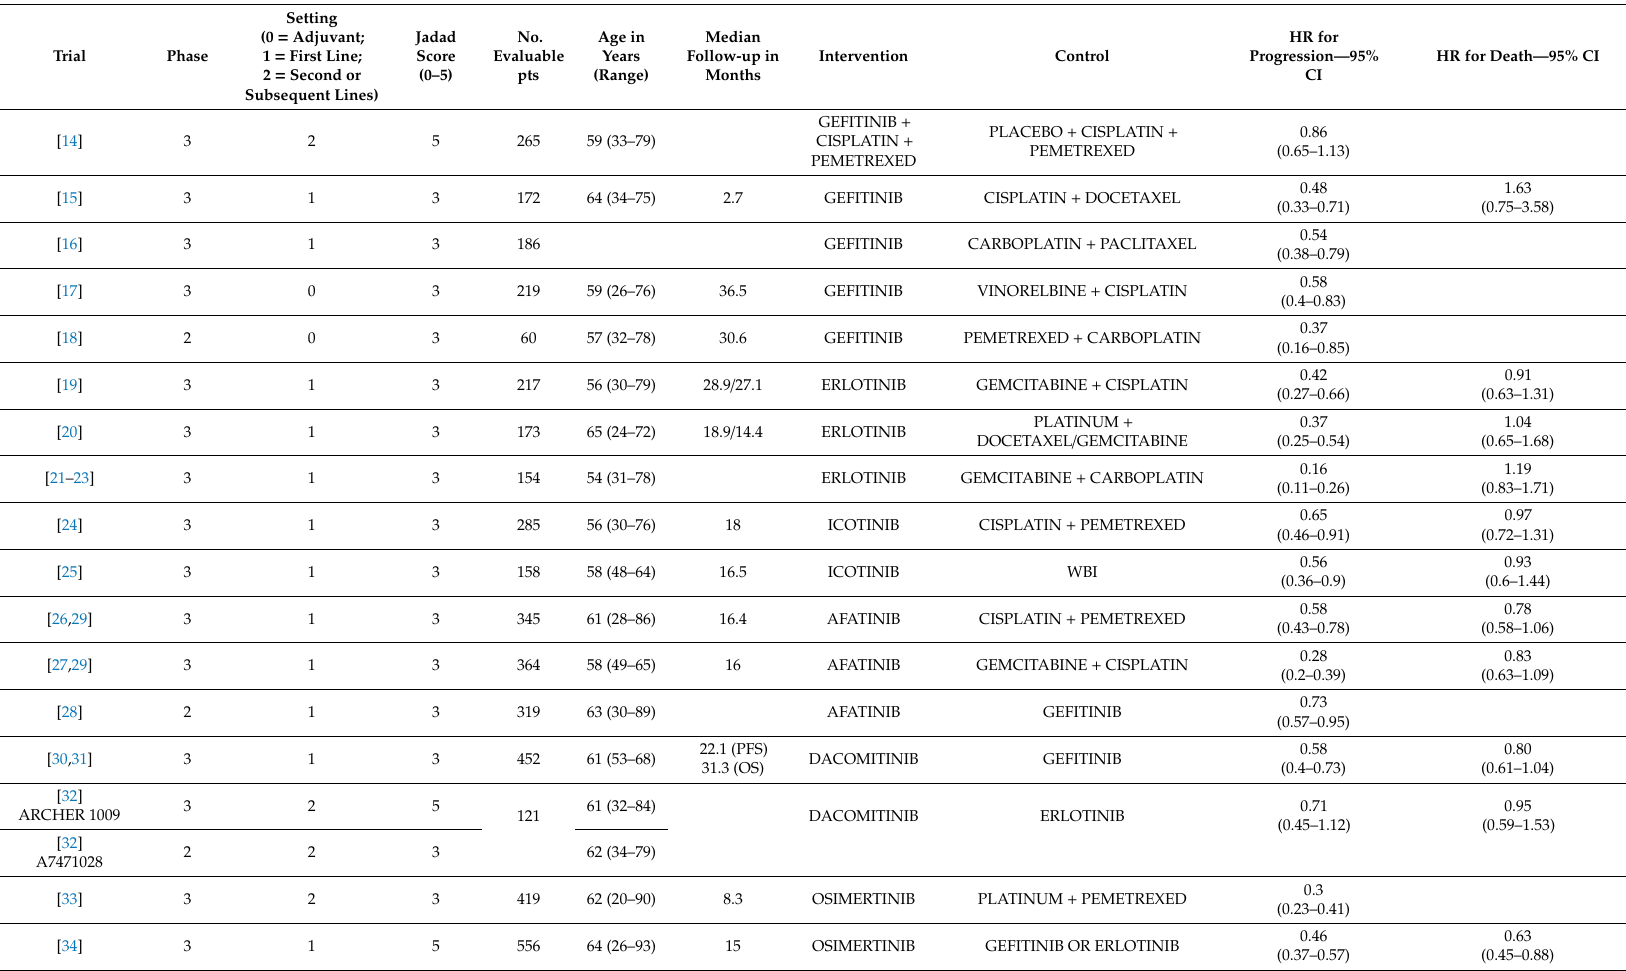
Table 1. Main characteristics of included trials. No = number; pts = patients; HR = Hazard Ratio; CI = Confidence Interval; WBI = Whole Brain Irradiation.